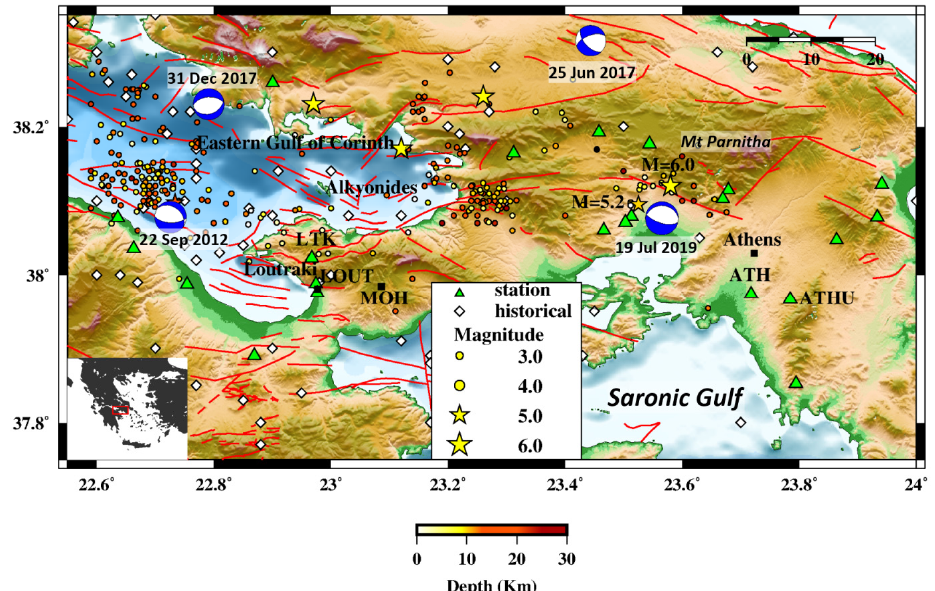
Figure 1. Geotectonic map of the broader area of the Eastern Corinth Gulf and Western Attica. Earthquakes marked by circles (for M w < 5.0) and stars (M w ≥ 5.0) (colored according to the included depth color bar) belong to the catalog used in the current study, obtained by the International Seisomological Centre (ISC), between 2008 and February 2021. Yellow stars indicate events between 1900 and 2008 along with historical earthquake locations (white diamonds) and faults (red lines) after [31] are presented. Focal mechanism solutions were acquired from the Seismological Laboratory of the National and Kapodistrian University of Athens (NKUA-SL). Sensor locations (triangles) and sites of high interest (squares) are also shown. Inset: Greece with the study area marked (rectangle).